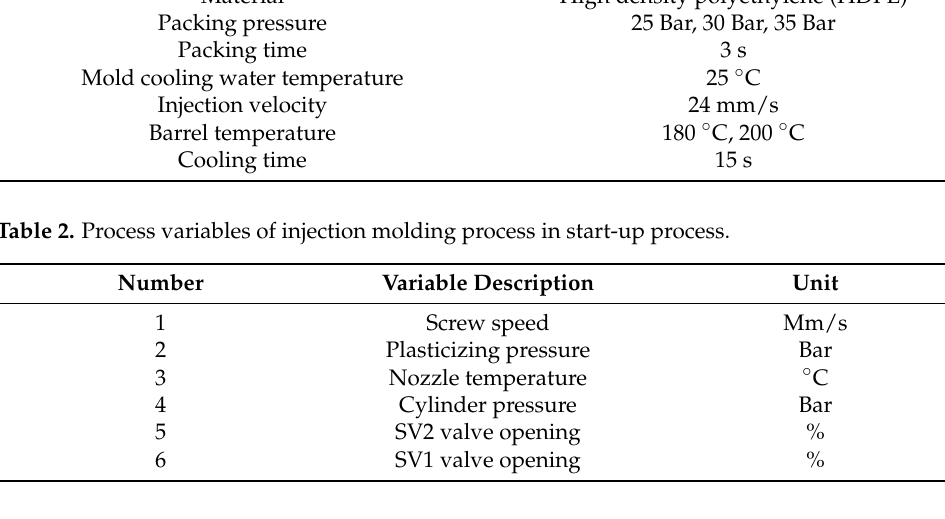
Table 3. Different operation modes caused by different packing pressure (PP) and different barrel temperature